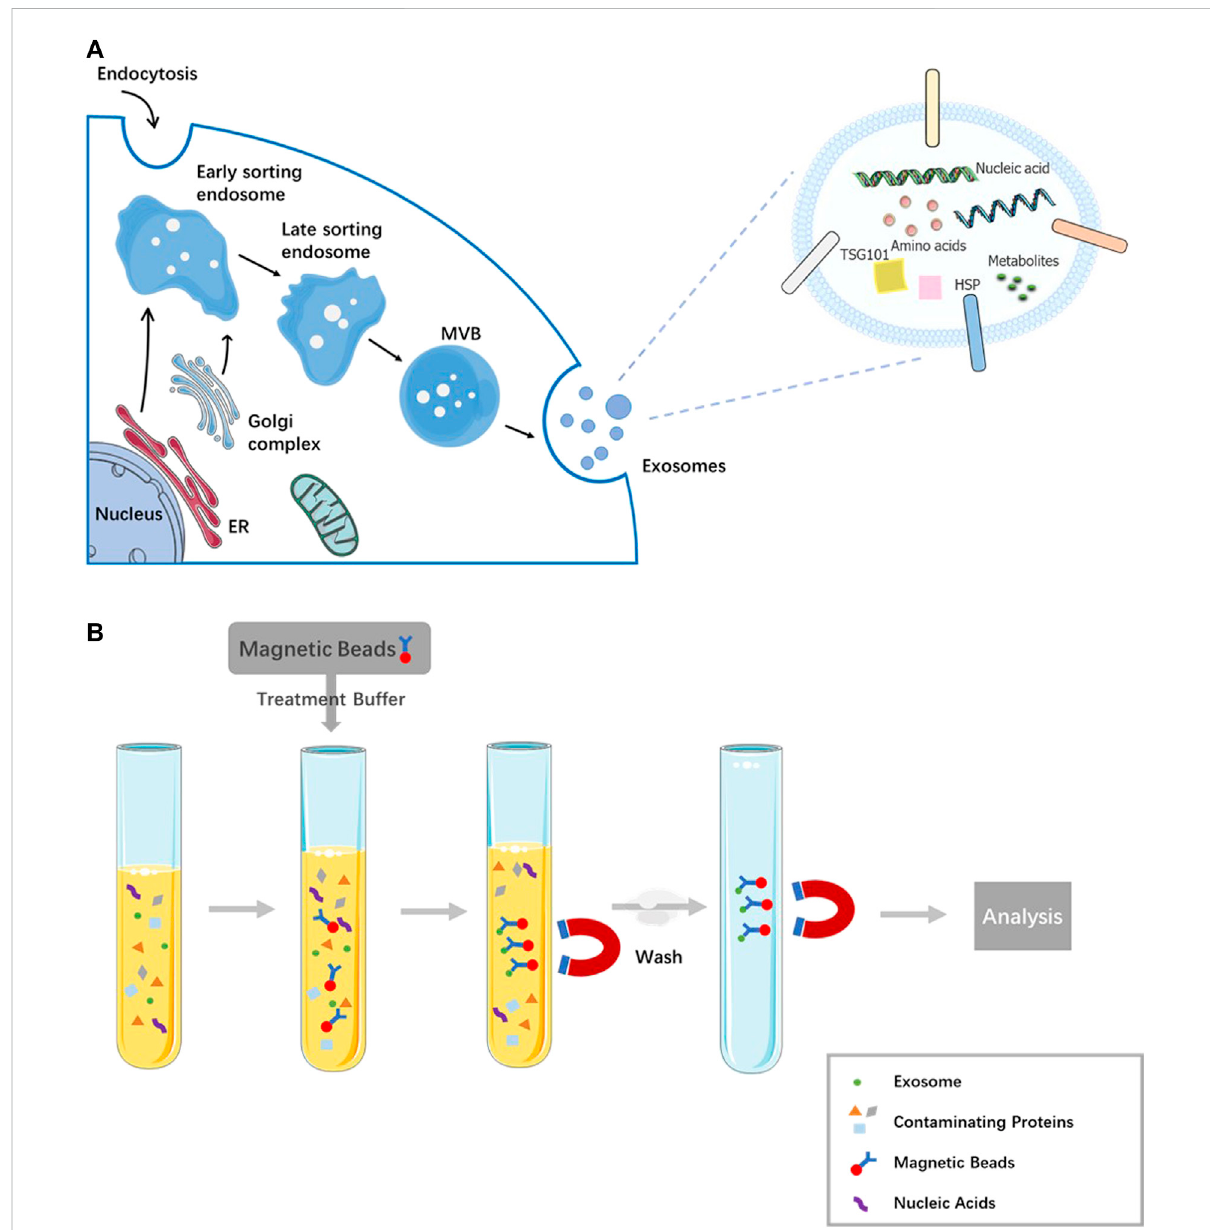
FIGURE 1 Biogenesis and its contents of exosome and magnetic bead af fi nity exosome isolation method. (A) The process production and overall composition of an exosome. (B) The scheme of magnetic bead af fi nity for exosome extraction.